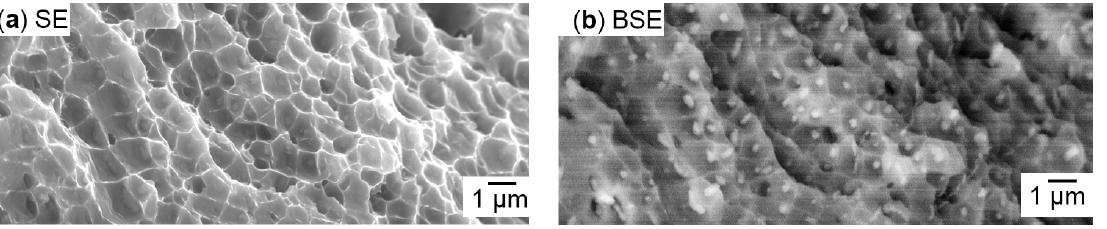
Figure 9. Vertical heat-treated ( a ) overview; ( b ) detail with rounded surfaces; ( c ) dimple structures.